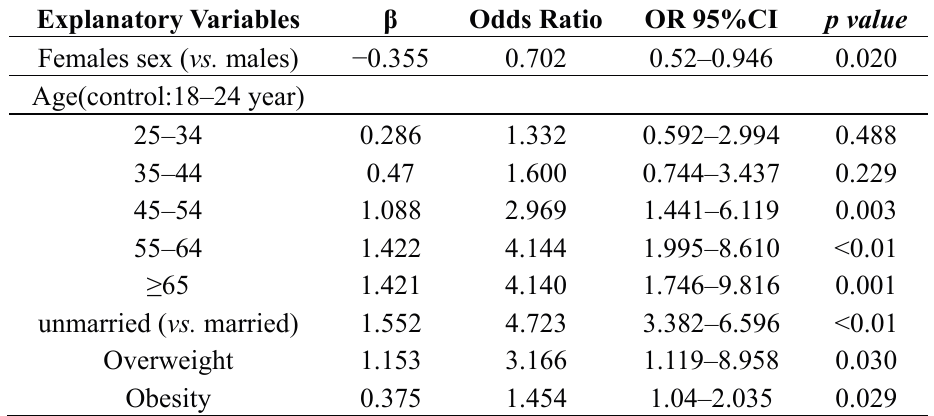
Table 4. Multivariate adjusted odds ratios (95% CI) for factors predictive of diabetes. Explanatory Variables